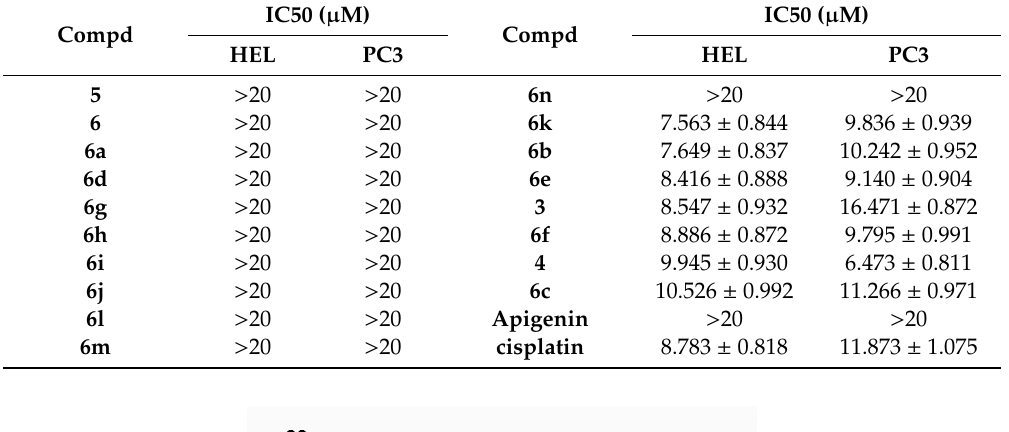
Table 1. IC 50 values of the flavone derivatives against the growth of the human erythroleukemia cell line (HEL) and the prostate cancer cell line (PC3).